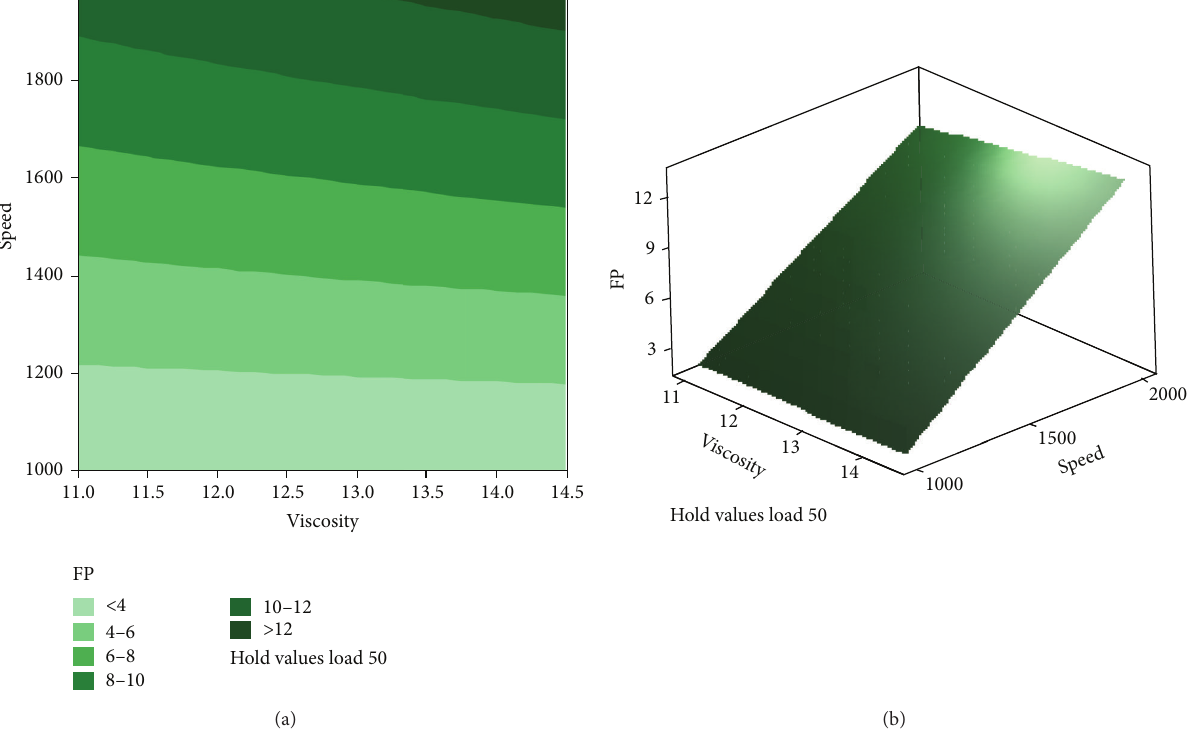
Figure 5: (a) Contour plot of FP versus viscosity and speed at a load of 50 Nm. (b) Response surface plot of FP versus viscosity and speed at a load of 50 Nm.